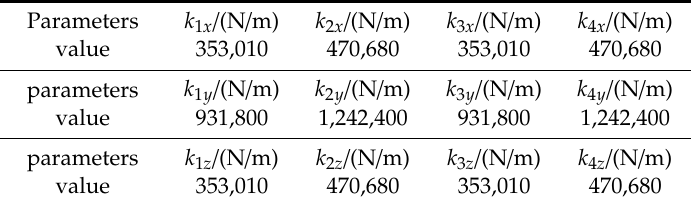
Table 1. Elastic support simulation parameters